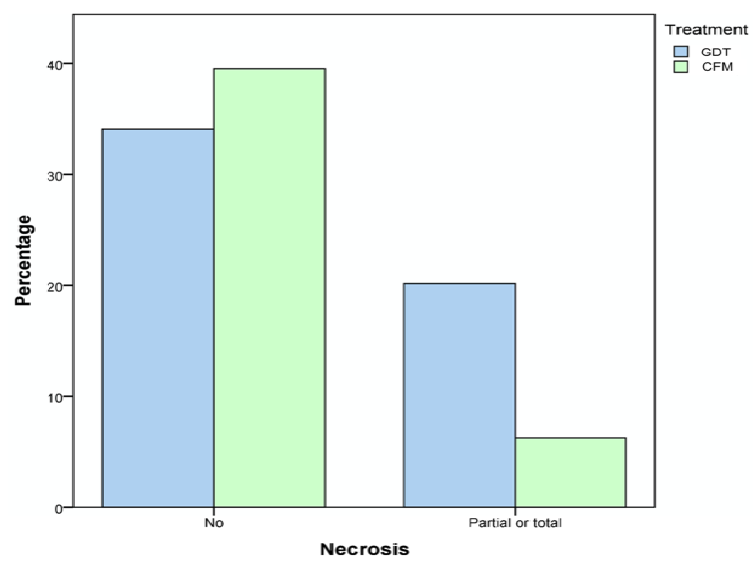
Figure 6. Free flap necrosis rate (%). One-year survival did not differ between groups (CFM 95.6% vs. GDT 86.8%, p =